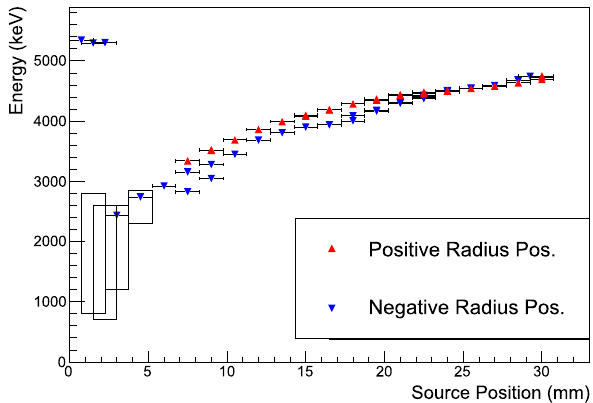
Fig. 6 The centroids of the α energy peaks in each data set; cer- tain positions were studied in multiple data sets. Negative (positive) radius positions are indicated by blue downward-pointing (red upward- pointing) triangles. For scanning positions with significant low-energy tailing, the black box depicts the estimated full energy range of α events. At positions that are partially or completely incident on the point-contact, an additional peak appears at nearly the full incident α energy. The vertical error bars (not visible) depict the uncertainty in the peakpositionfromthemaximum-likelihoodfitofthepeaks,andthehor- izontal errors depict the 0.75mm estimated uncertainty of the source position. The observed instability of the α peak energies is discussed